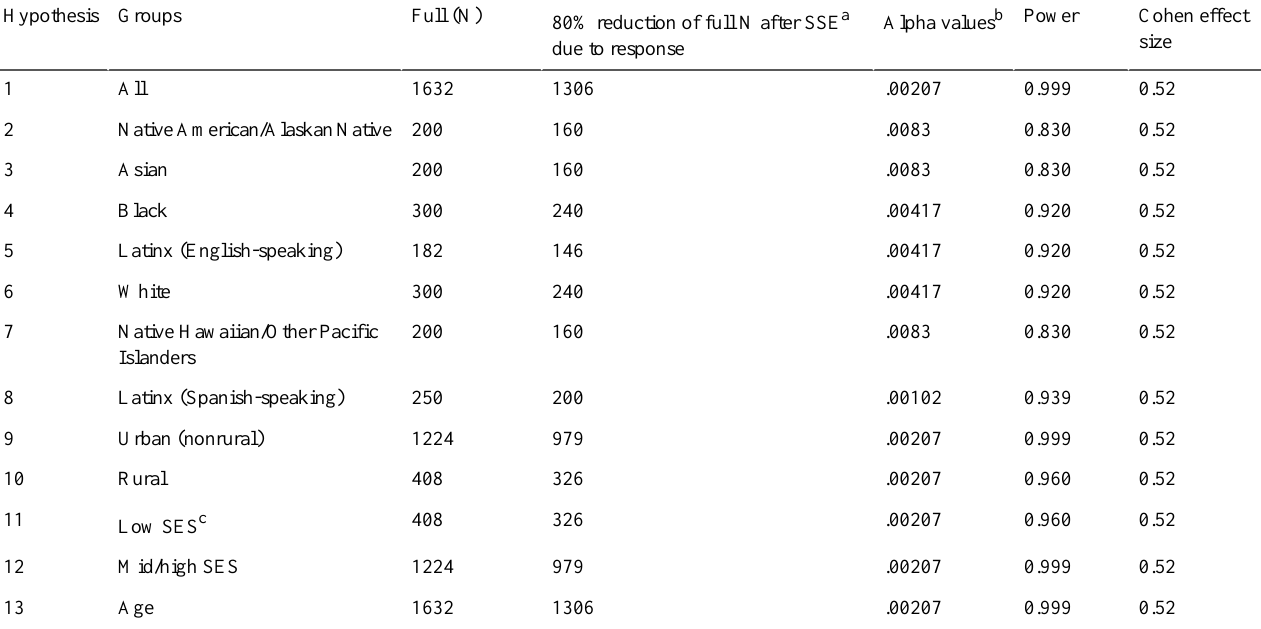
Table 2. Power analysis by hypothesized